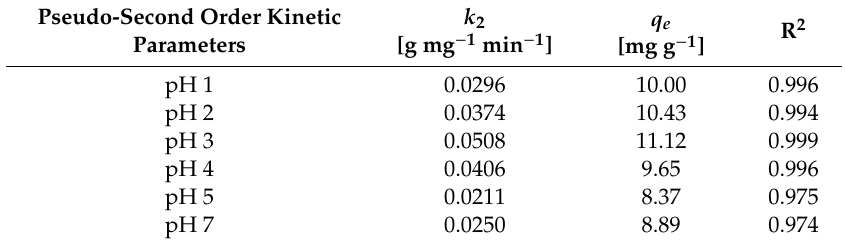
Table 1. Calculated parameters from the second order kinetic model of the arsenic removal kinetics with CTO, in function of